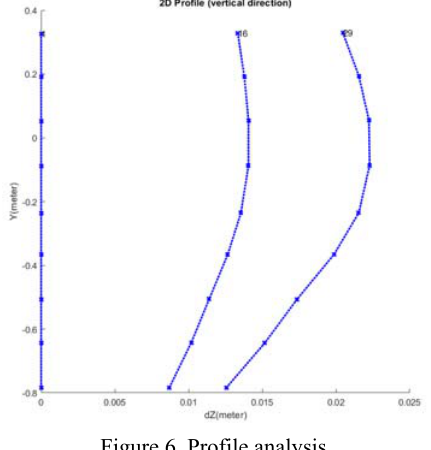
Figure 6. Profile